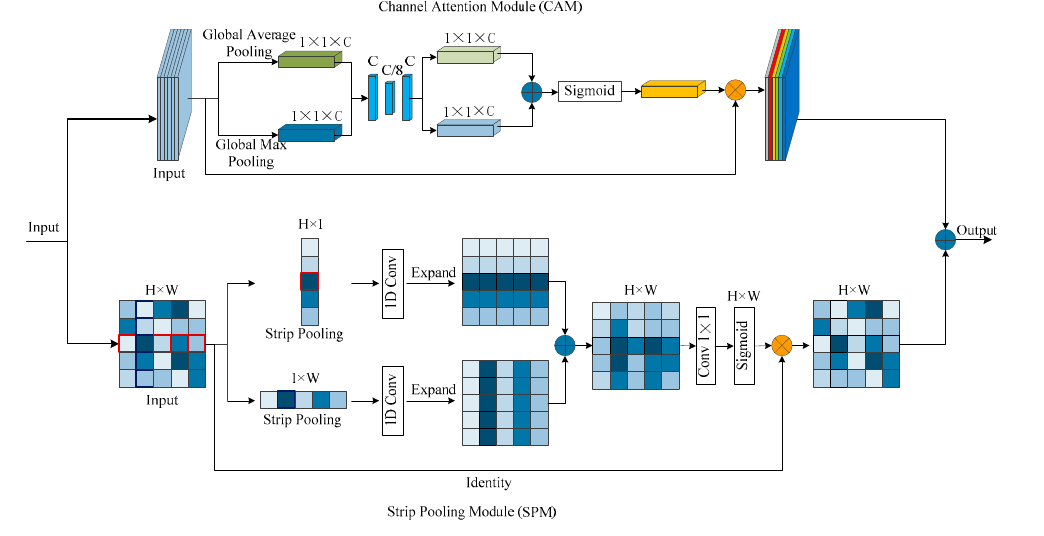
Figure 3. The structure of LCAM.